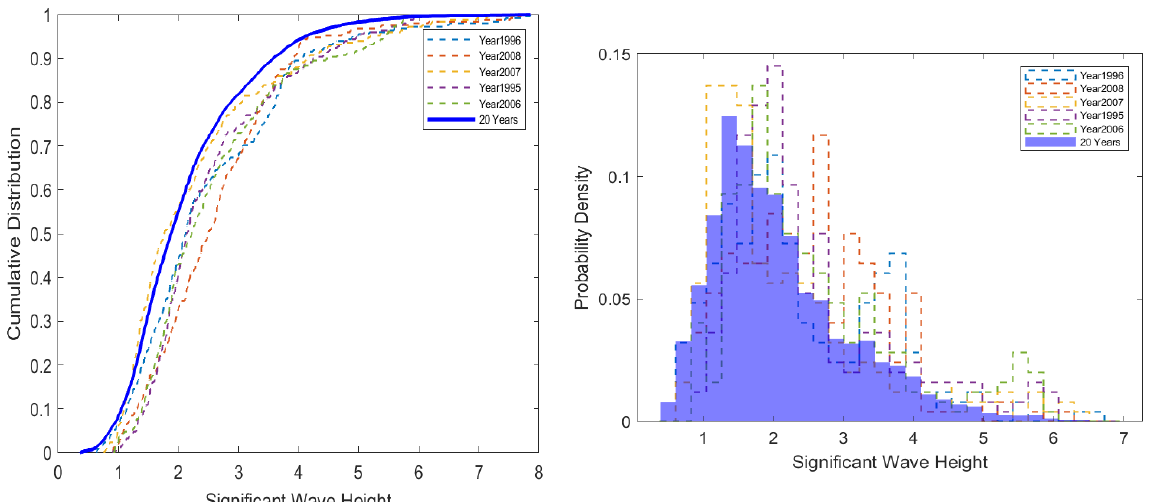
Figure 2. The cumulative distributions ( left ) and probability densities ( right ) of the significant wave height in March from five candidate months yielded by the component of JS divergence.